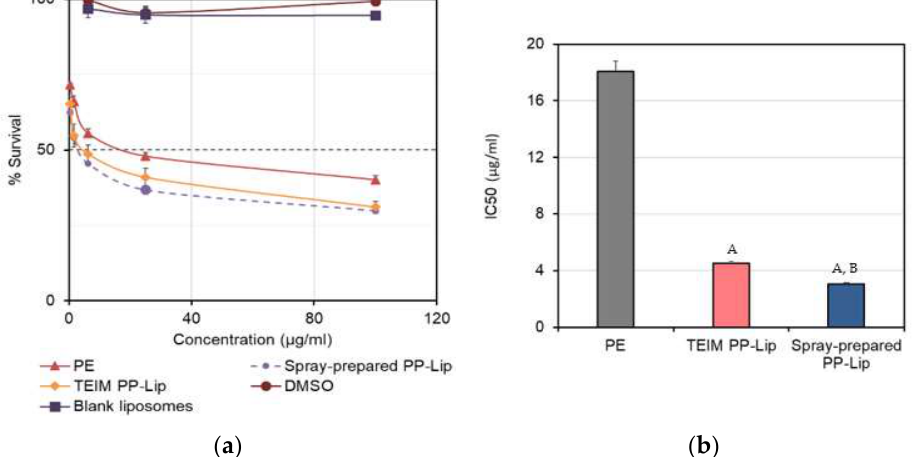
Figure 6. ( a ) Dose–response curves representing the cytotoxic activity of propolis extract (PE), TEIM-prepared PP-Lip and spray-prepared PP-Lip against A375 human melanoma cells, and ( b ) IC50 values (μg/mL) of different formulations. Values are average and n = 3. In the bottom figure, A represents a significant difference from PE ( p < 0.01), and B means significantly different from TEIM PP-Lip ( p < 0.05).